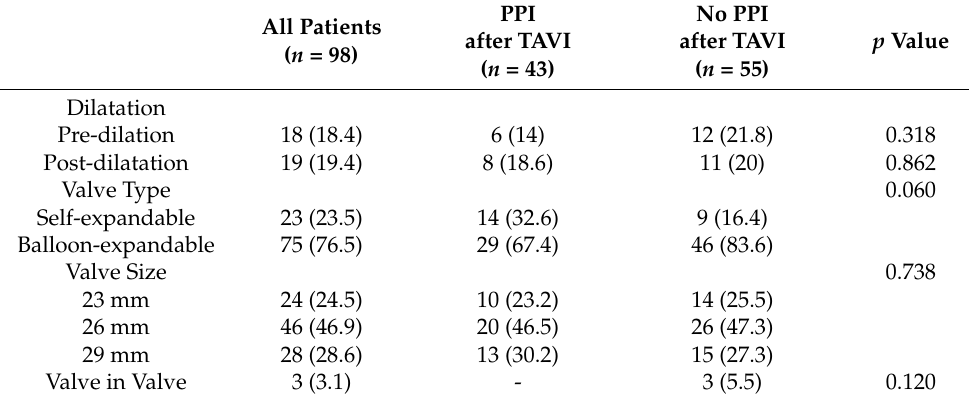
Table 2. Procedural characteristics of patients with pre-existing